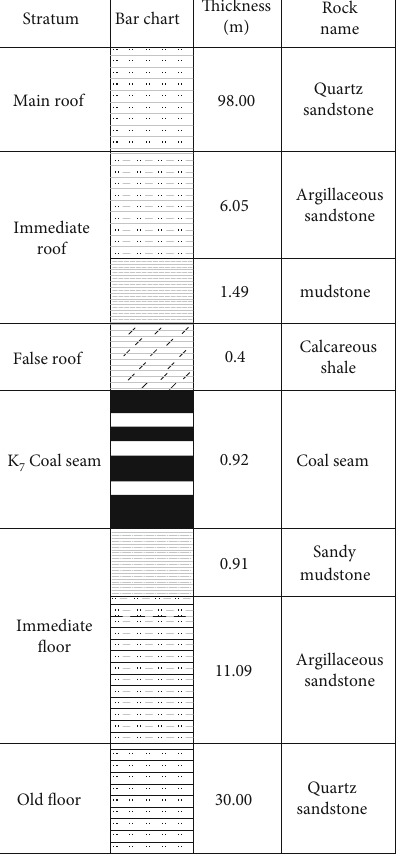
Figure 1: Geology drill-columnar